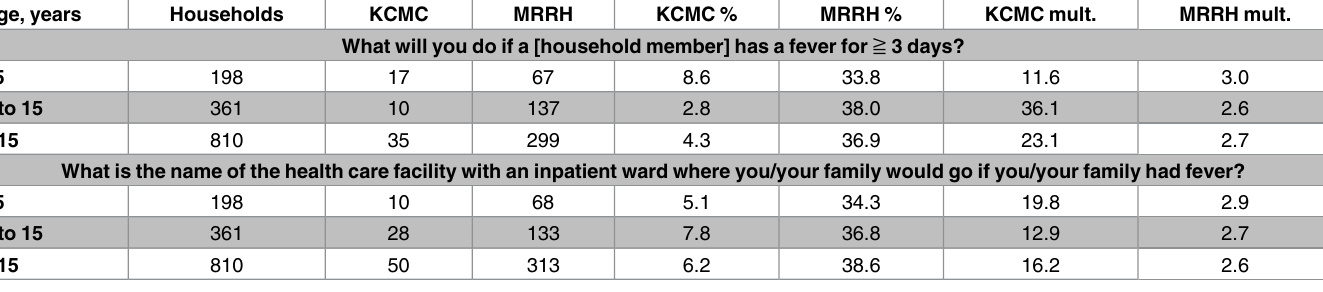
Table 1. Multipliers based on responses to relevant questions in healthcare utilisation survey, Moshi Rural and Moshi Urban Districts, Tanzania, 2011.